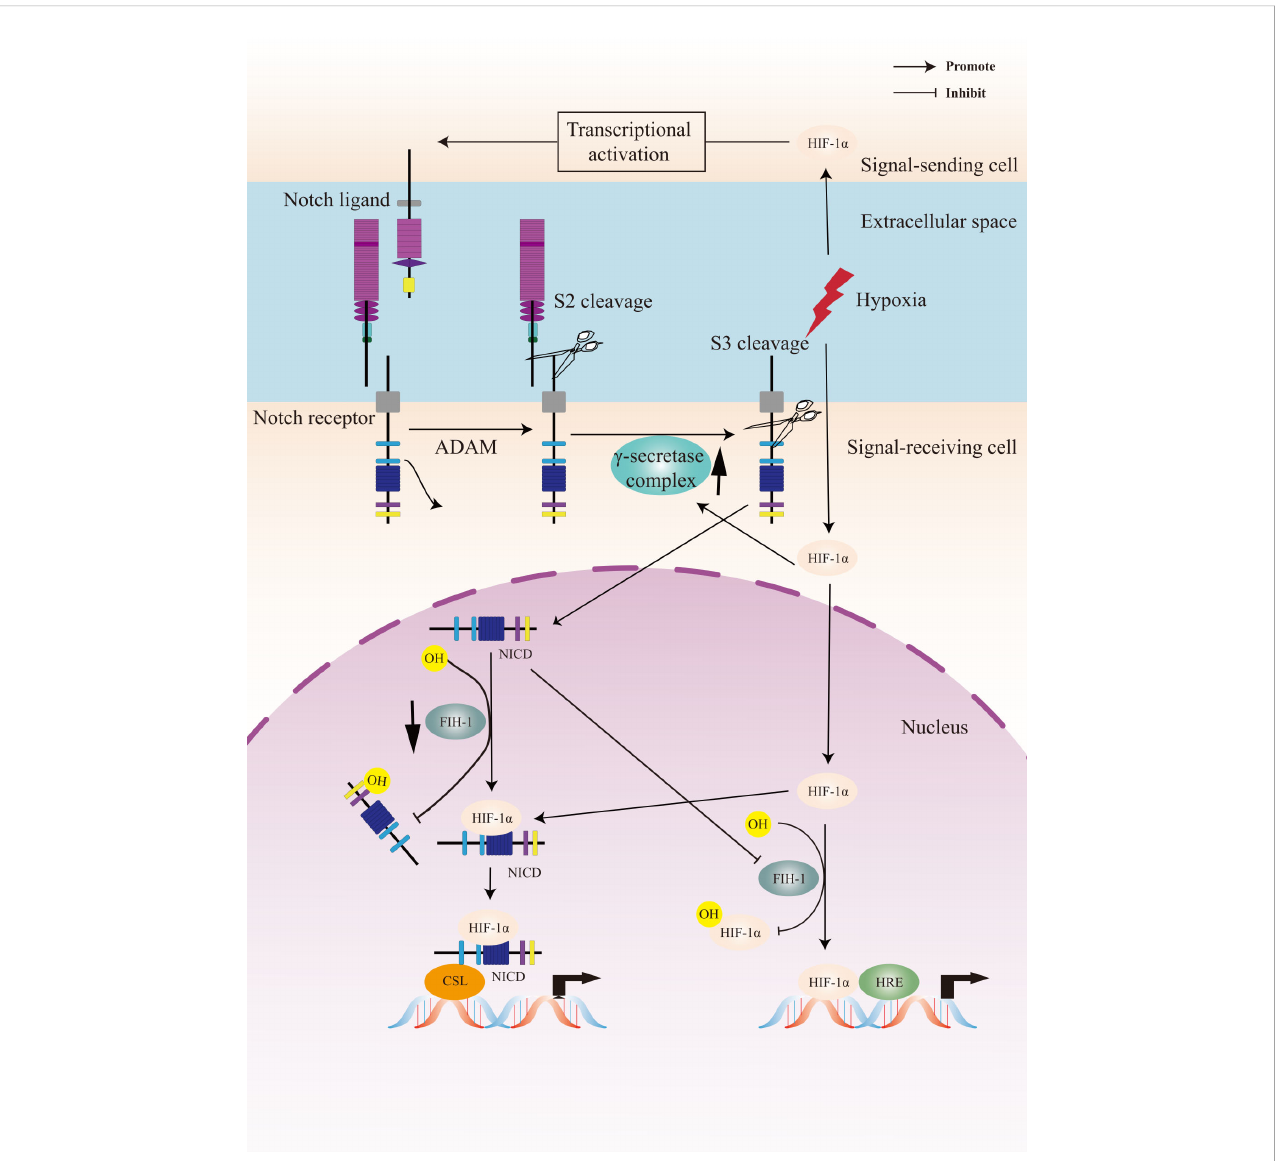
FIGURE 2 A Crosstalk between Notch signaling and hypoxia pathway. Upon activation of the Notch receptor, the Notch intracellular domain (NICD) accumulates in the cell nucleus and activates target genes. Hypoxia induces the canonical hypoxia response pathway, which involves the activation of hypoxia response element (HRE)-driven target genes. Under hypoxic conditions, hypoxia-induced factors-1 a (HIF-1 a ) potentiates Notch-dependent activation of target genes through interaction with the NICD. Besides, HIF-1 a interacts with g -secretase and upregulated g -secretase activity. Factor-inhibiting HIF-1 (FIH-1) hydroxylates the asparagine residues of HIF- a and NICD, leading to inactivation of Notch and hypoxia signaling pathways. Hypoxia decreases the activity of FIH-1. In addition, FIH-1 binds NICD more ef fi ciently than HIF-1 a . NICD sequesters FIH-1 away from HIF-1 a , indirectly resulting in an activation of HRE-driven target